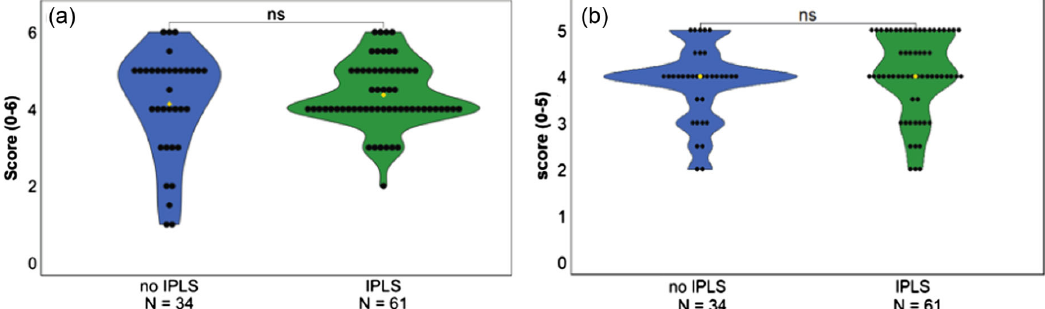
4. Rubric scores for problems requiring implementing a model that had been previously used in class, from non-IPLS students (blue envelope around black dots) and IPLS students (green envelope around black dots): (a) part (a) of the fluids task (code in Table 1), (b) parts (a) and (b) of the thermodynamics task (code in the Appendix). Each student ’ s score is represented by a black dot, and the median score is represented by a yellow dot; “ ns ” stands for not significant and means p > 0 . 05 . Bayesian odds ratios in favor of the null hypothesis were (a) 2.8 and (b)